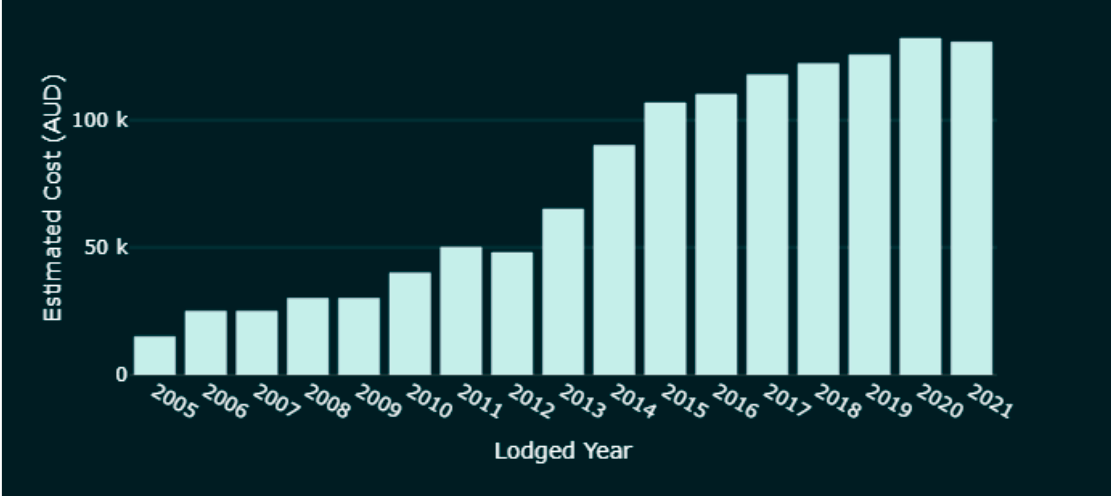
Figure 26. Average compared to median estimated cost of determined DAs lodged between 2005– 2021.